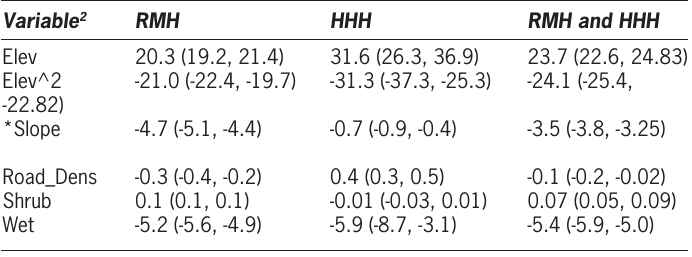
Table 5. Mean selection coefficients (90% confidence intervals in parentheses), across individual caribou 1 for population-level habitat selection functions in central Alaska, USA,